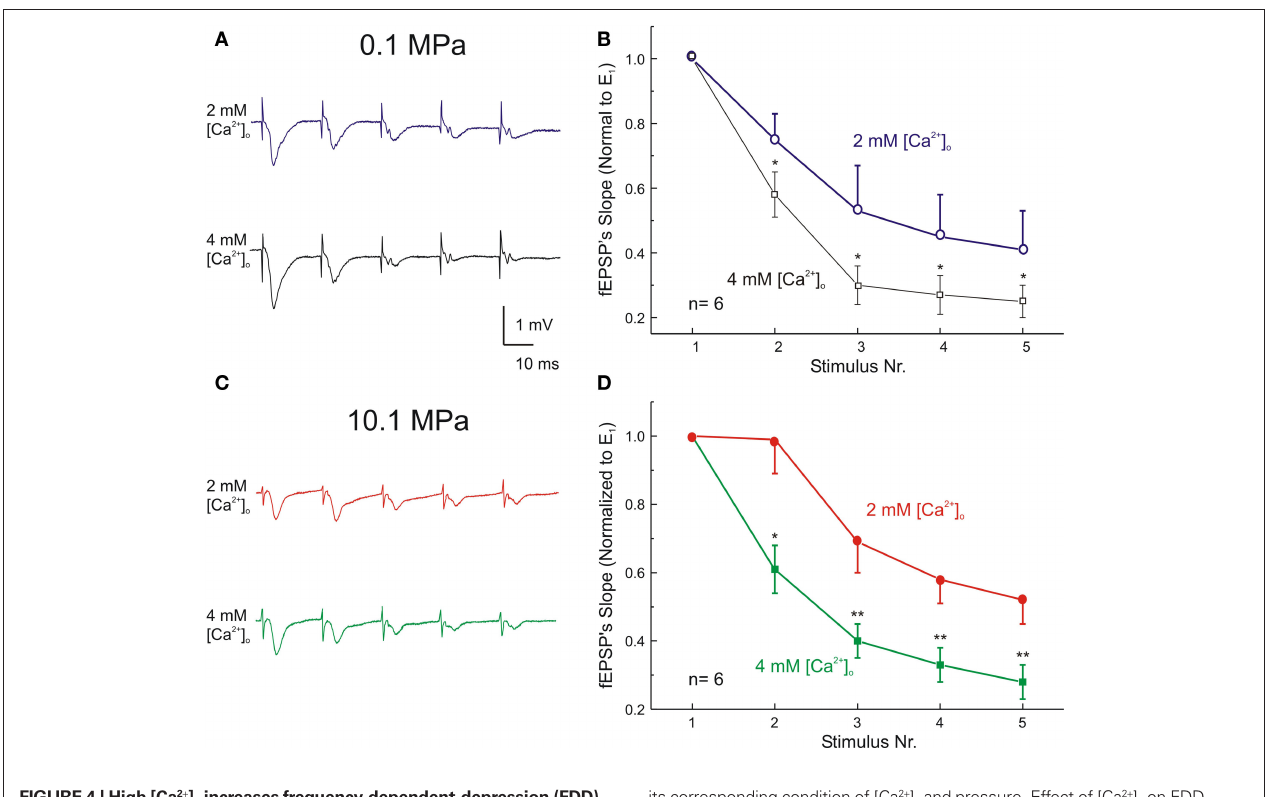
Figure 4 | High [Ca 2 + ] increases frequency-dependent-depression (FDD) o at atmospheric pressure. Left: Dendritic recordings showing the effect of [Ca 2 + ] on trains of 5 fEPSPs (50 Hz) at pressure of 0.1 MPa (A) and 10.1 MPa o (C) . Calibration bars are the same for both conditions. Right: Statistical analysis of FDD at 50 Hz. Each E was normalized with respect to its E x